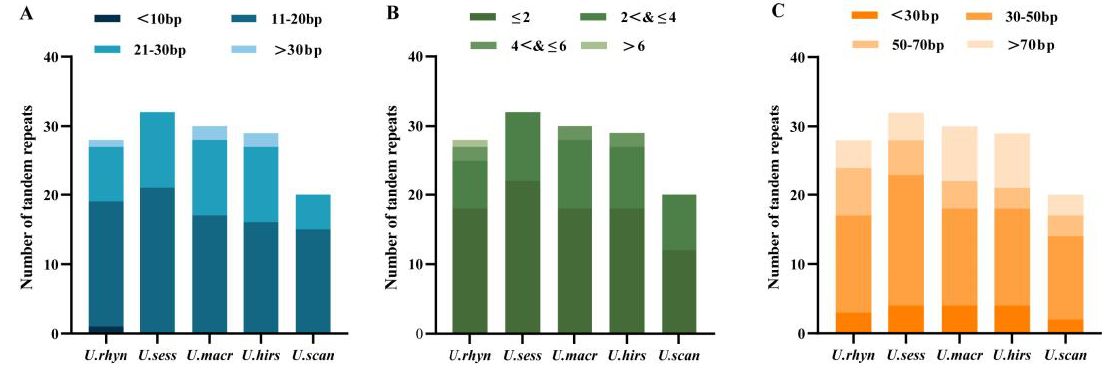
Figure 6. Tandem repeated sequence analyses for five Uncaria species in cp genomes. The number of tandem repeats with various period sizes, copy counts, and sequence lengths are shown in ( A , B , C ), respectively.